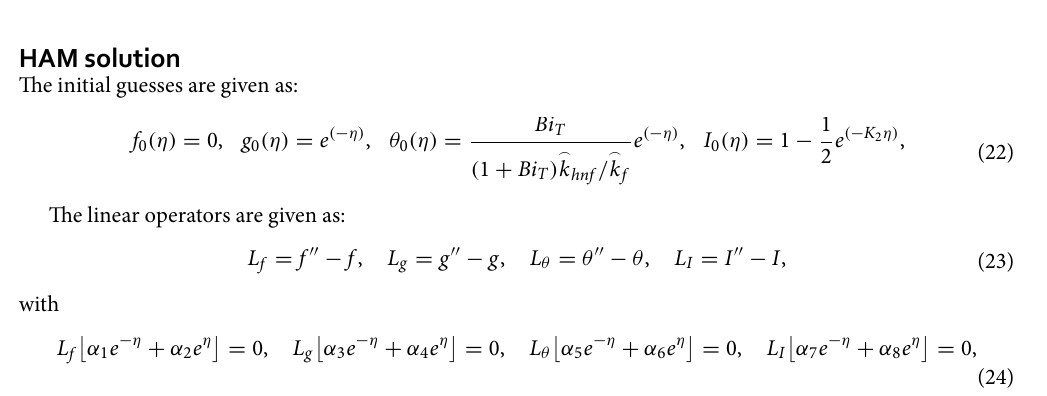
φ 1 + φ 2 Pr Bachok et al. 48 Maleque and Sattar 49 Kelson and Desseaux 50 Present results Table 2. Comparison of − θ ′ ( 0 ) with reported results when all other parameters are zero.